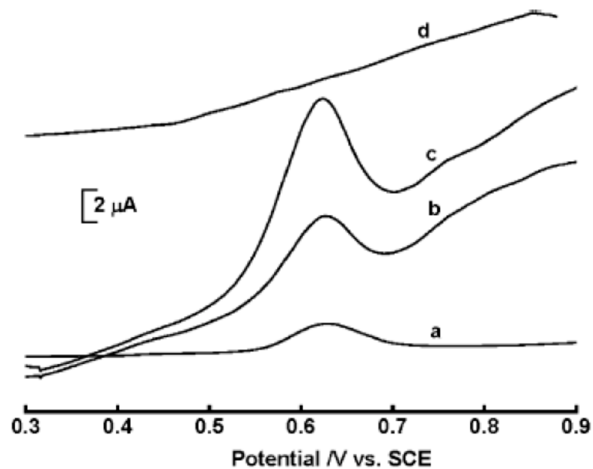
Figure 17. Square-wave voltammetric responses of Sudan I after 2 min accumulation. (a) 0.1 mg L − 1 Sudan I at unmodified CPE; and (b–d) 0.1, 0.2, and 0 mg L − 1 Sudan I at MMT-Ca modified CPE. Pulse height = 25 mV, pulse width = 10 ms, scan rate = 100 mV s − 1 . Reprinted with the permission of Reference [51]. [License Number 5067500862861].